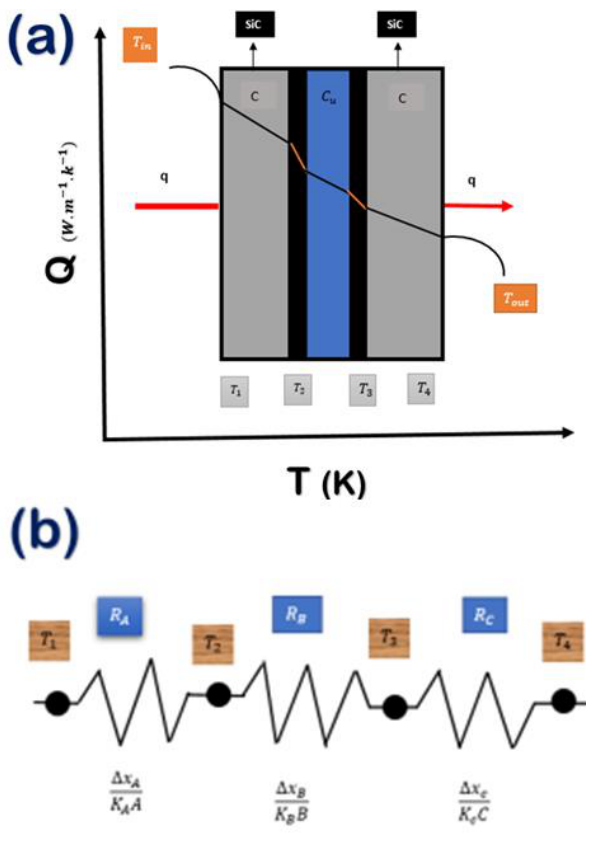
Fig. 1. (a) Schematic diagrams of heat transfer in the solid- carbon/ liquid copper-silicon systems and (b) thermal resistance of all three